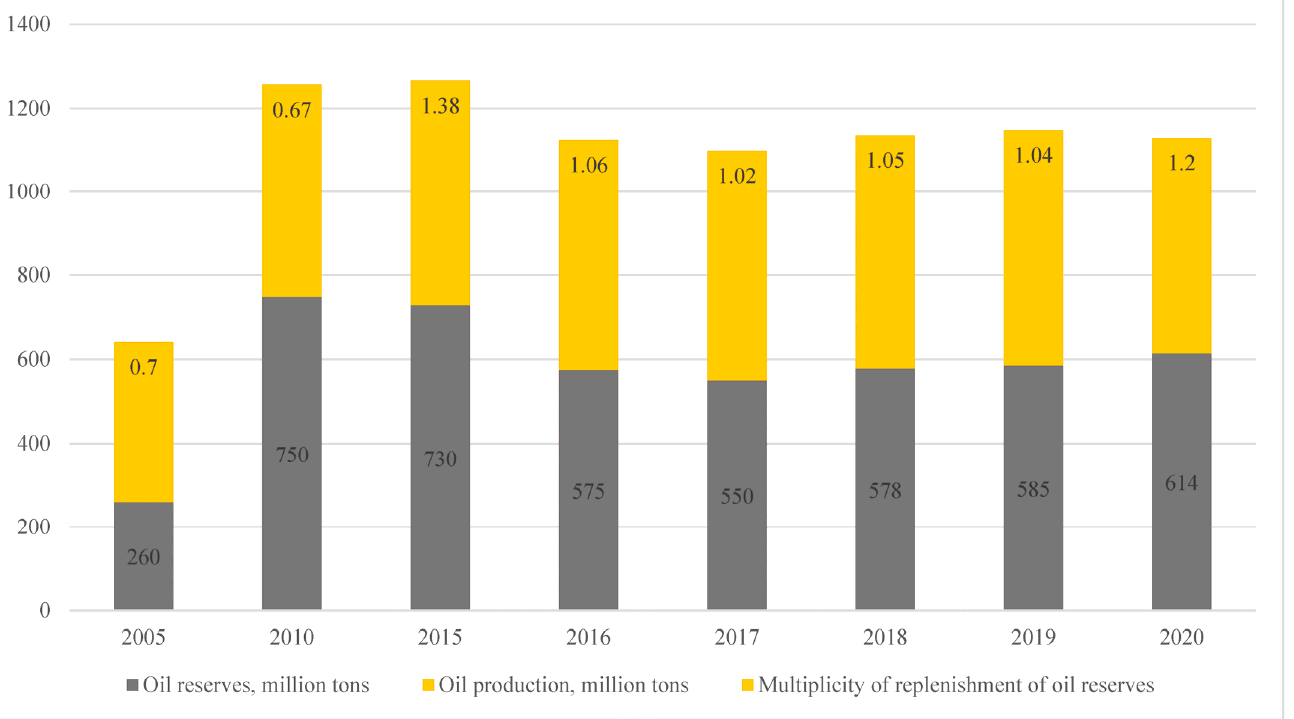
Figure 2. Dynamics of oil production and availability of oil reserves in the Russian Federation for 2005–2020. Compiled by the authors according to: Regions of Russia. Socio-economic indicators.